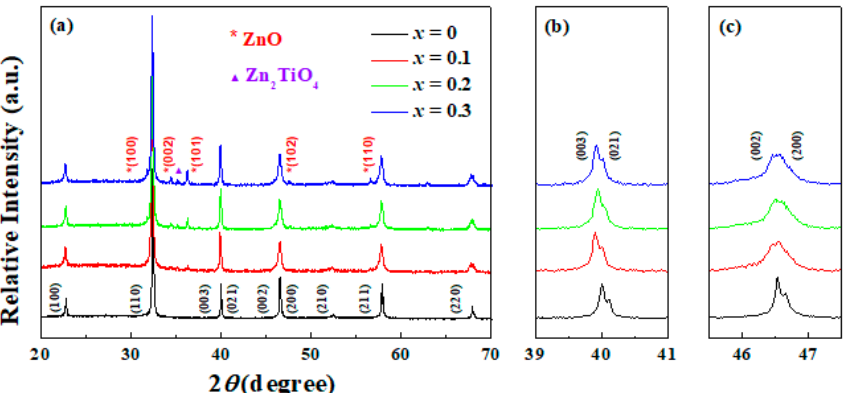
Figure 1. XRD pattern of BNKT-BT- x ZnO composites in a 2 θ range of ( a ) 20° to 70°, ( b ) 39° to 41° and ( c ) 45.5° to 47.5° at room temperature.